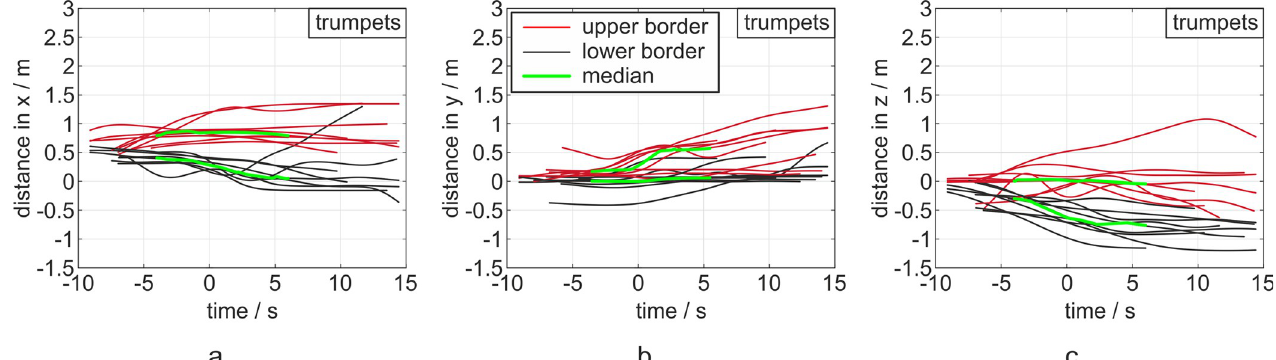
Fig 4. Diagrams of distances in x-, y- and z-direction (a, b, c) from left to right for the trumpets. The 0 point in the time-scale refers to the end of the task. Each task is represented by a red (upper border) and a black curve (lower border) indicating the maximum distances of the cloud in the respective directions. The median devolution in both directions is shown in green. The corresponding diagrams with color-coded notation of the three tasks are displayed in the S1 Fig.